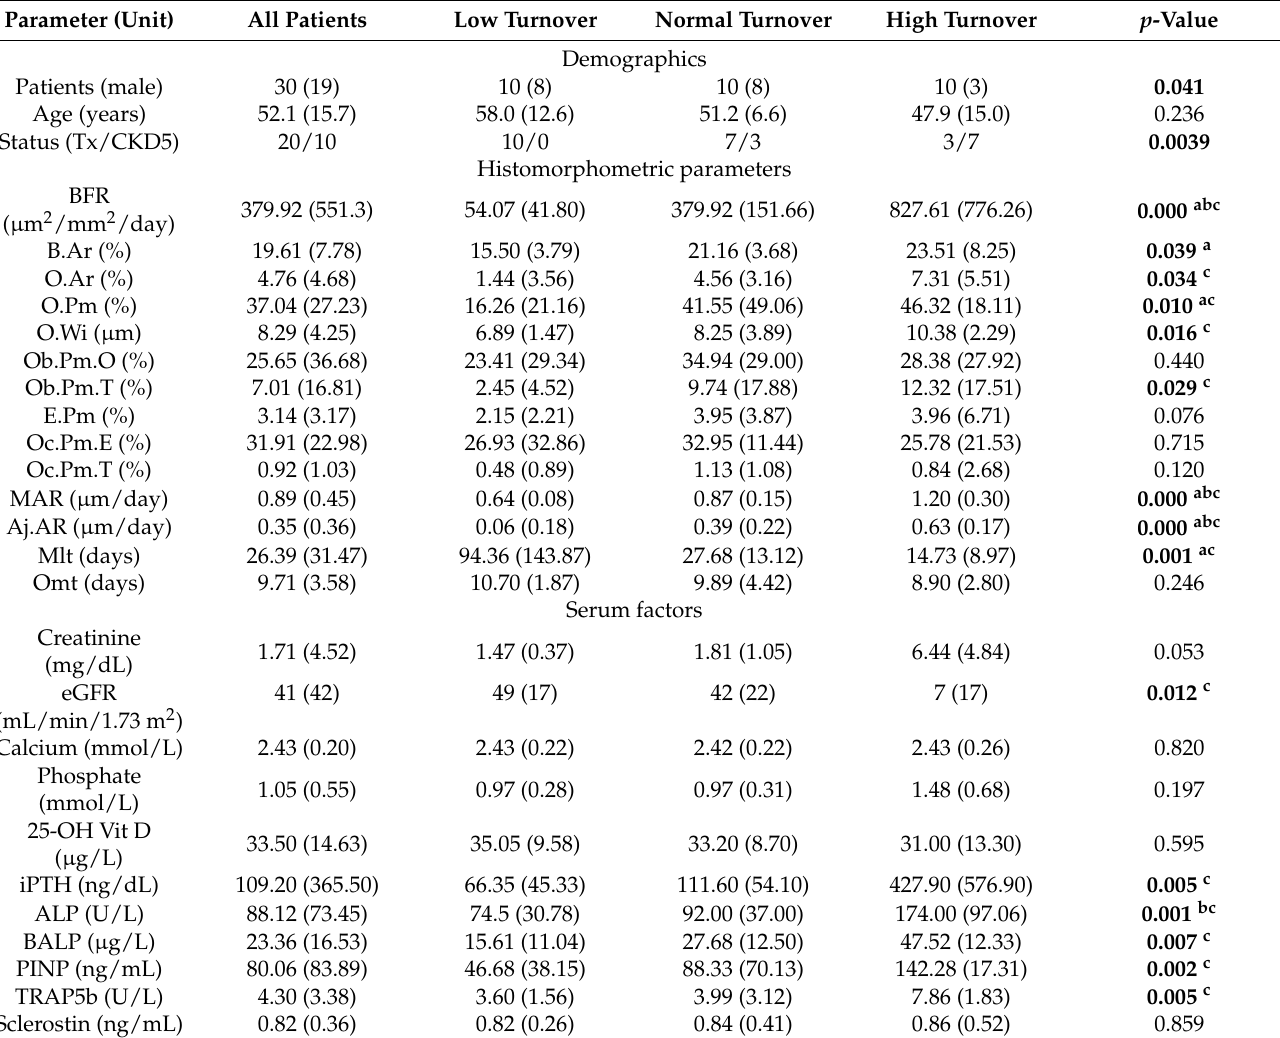
Table 3. Characteristics of the different patient